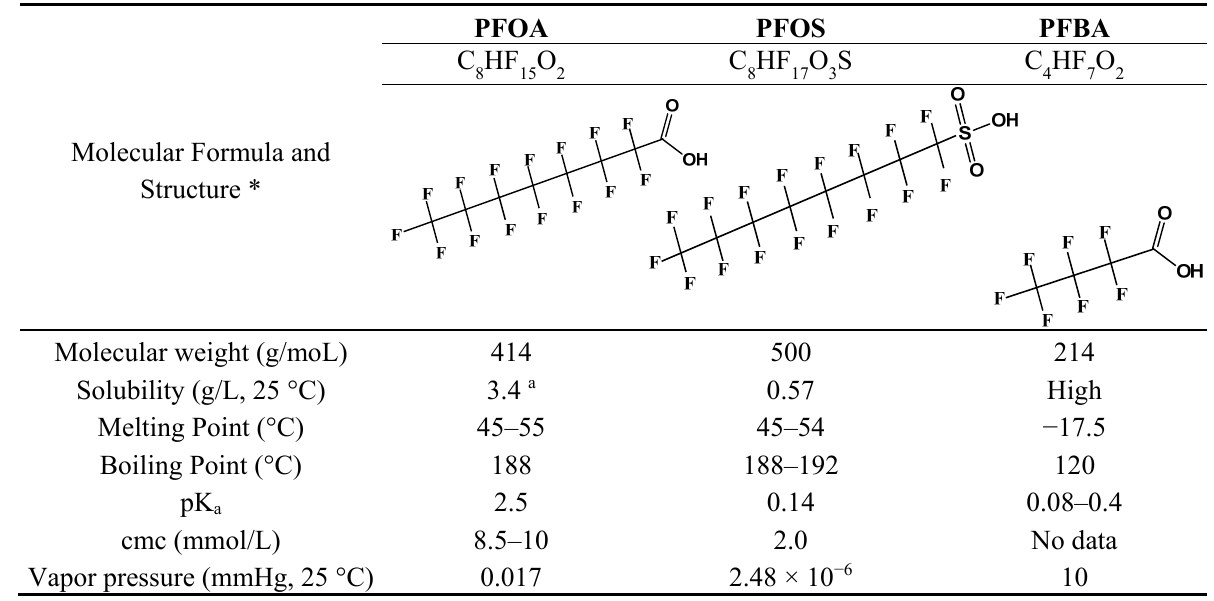
Table 1. Physicochemical Properties of PFOA, PFOS, and PFBA. Reproduced with permission from [94], Copyright 2014, American Chemical